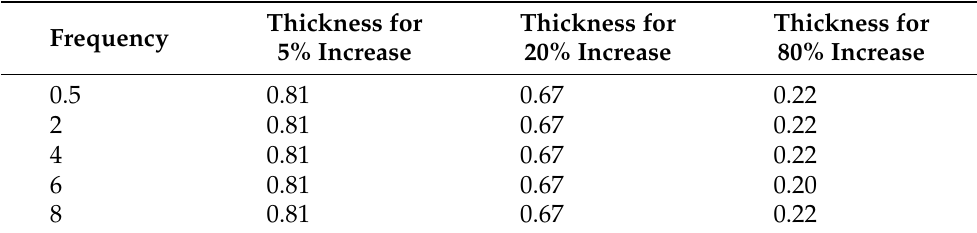
Table 5. Measured relative permittivity change of skin–olive oil double-layered configurations with